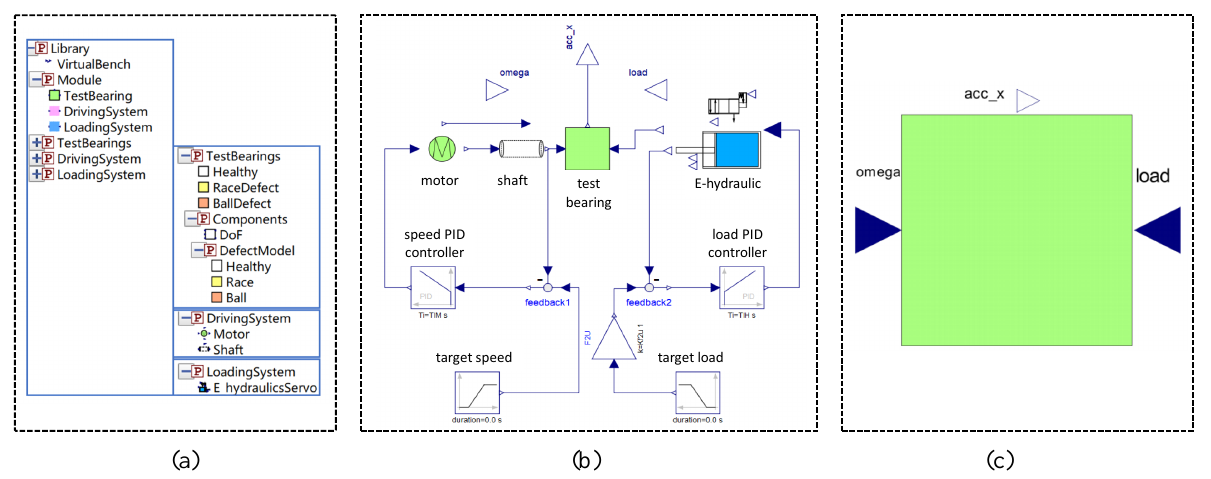
Figure 3. Bearing test bench in Modelica: ( a ) Component and module library; ( b ) Layout of virtual bearing test bench; ( c ) Interface of test bearing [15].